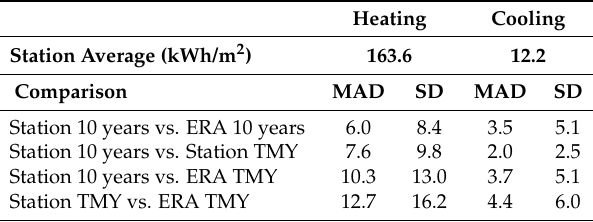
Table 3. Average energy consumption kWh/m 2 and statistical deviation between different data sources calculated according to Equations (5) and (6), for the single-family house